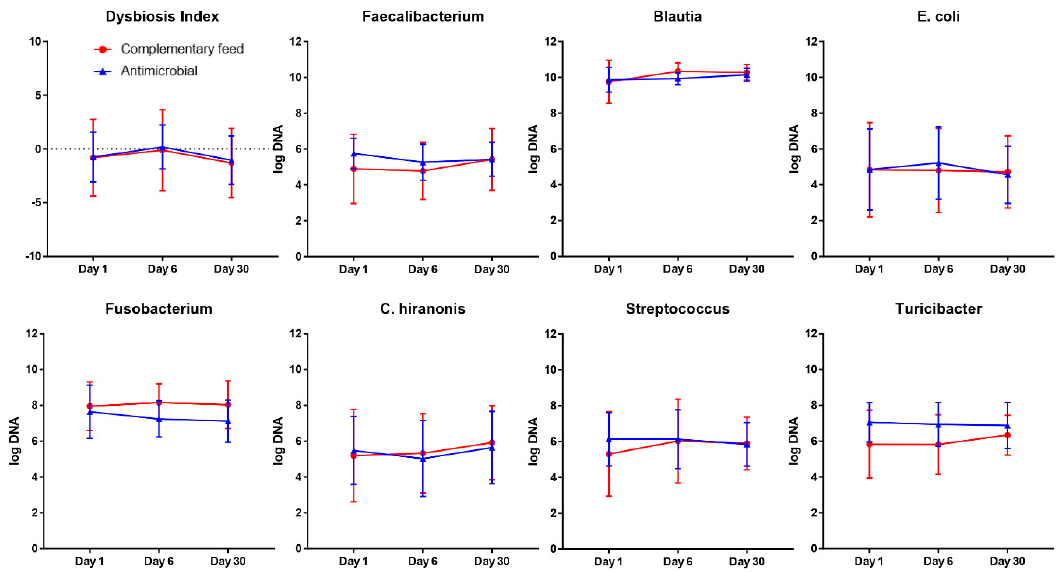
Figure 2. Bacterial taxa and the Dysbiosis Index in the groups of dogs treated with complementary feed (group A; red) and antimicrobials (group B; blue). There were no significant differences at any point in time between groups.